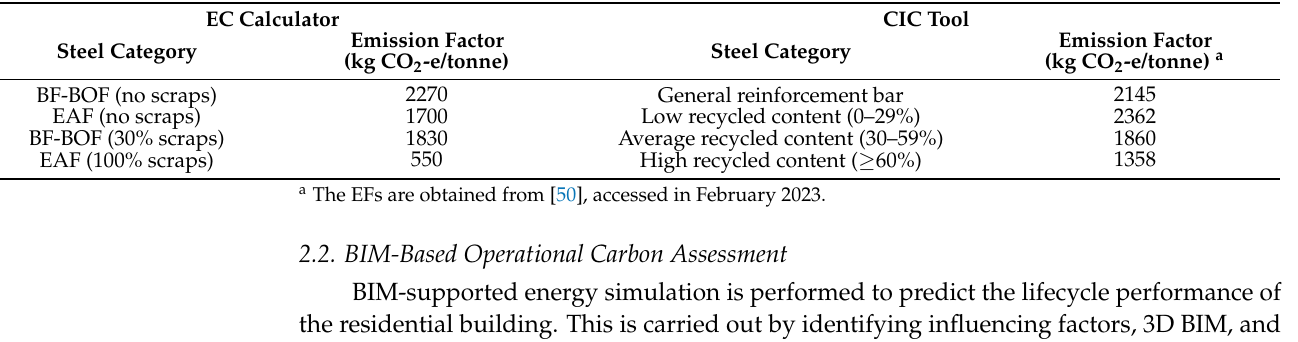
Table 5. Comparison of steel emission factors used in the